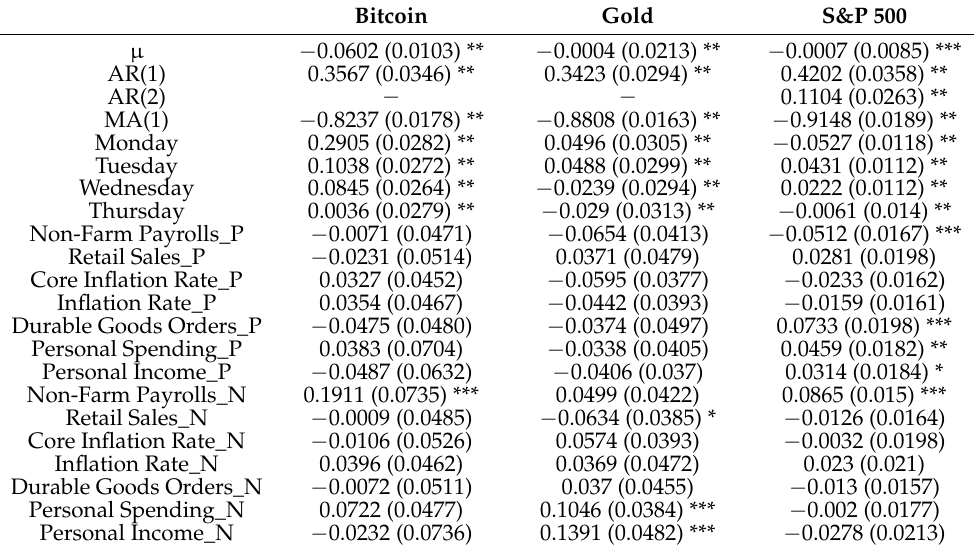
Table 6. Impact of the U.S. announcements on the observed assets’ volume.